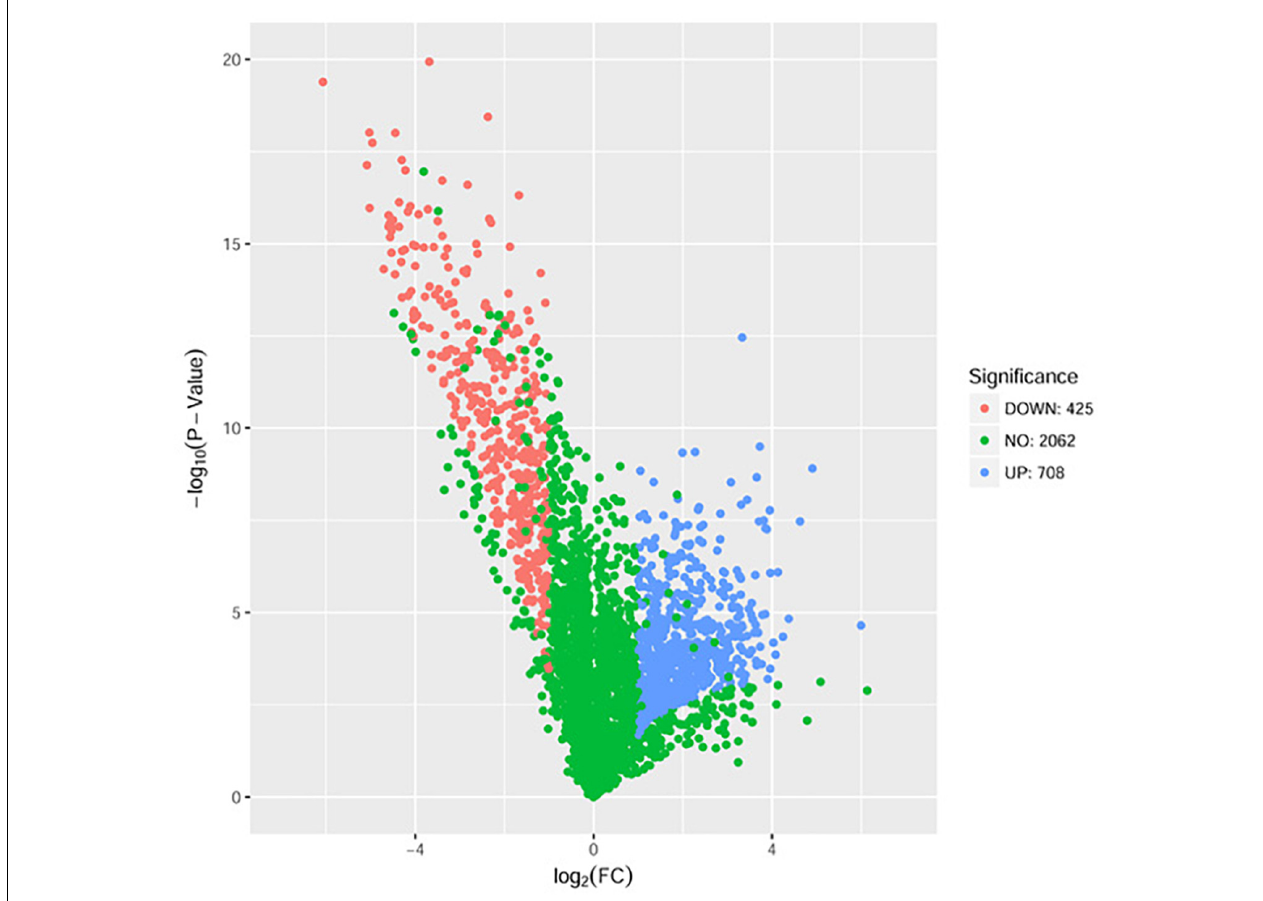
FIGURE 4 | Volcano plots of the differentially expressed genes based on proteome sequencing analysis of untreated and DADS-treated P. aeruginosa PAO1. Each protein is represented by a dot in the graph. The x -axis and y -axis represent the log 2 value of fold change and the t-statistic as –log 10 of p -value, respectively. The genes represented in blue (up regulated) and red (down regulated) are differentially expressed genes with > twofold change and a p -value <